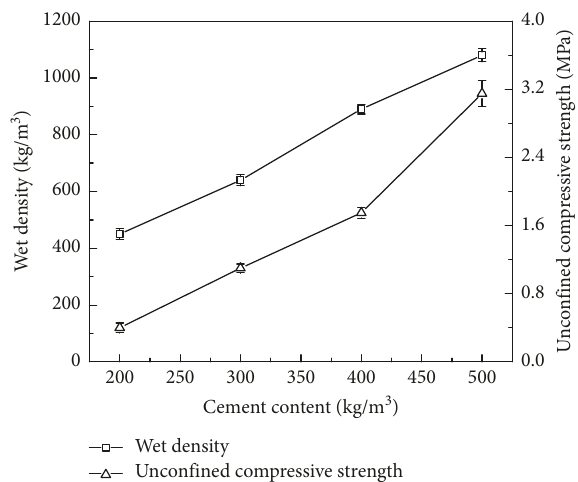
Figure 4: Influence of the cement content on the wet density and compressive strength of